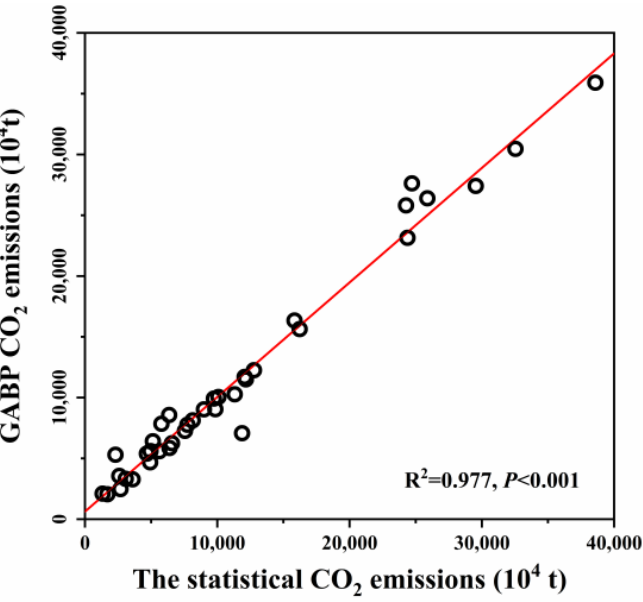
Figure 3. Scatter plots of total CO 2 emissions calculated from statistical energy consumption data and simulated CO 2 emissions by GABP neural networks of three agglomerations in 2019.